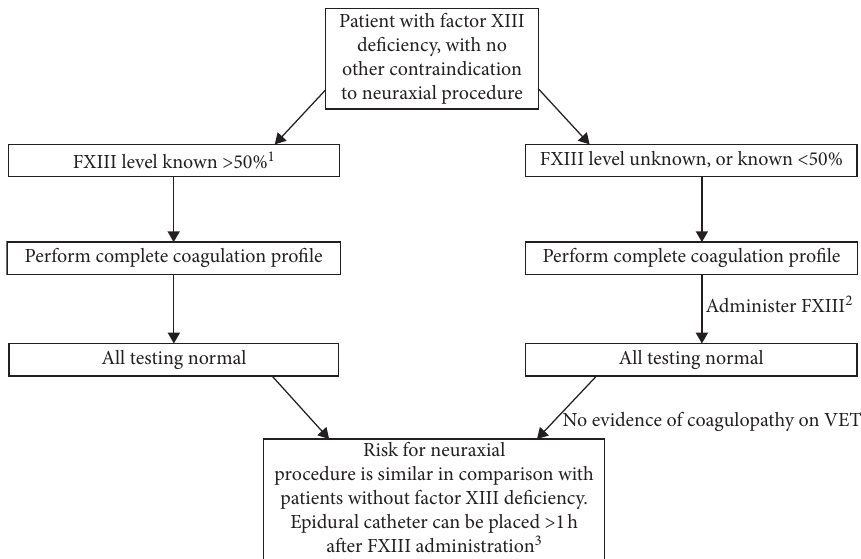
Figure 1: Algorithm for performing neuraxial procedures in patients with FXIII deficiency. VET: viscoelastic testing. 1 FXIII activity may be known by quantitative testing on admission, or calculated by a hematologist, taking into consideration patient’s medical conditions, comorbidities, timing of last dose, and quantitative assessment of prior response during the 3 rd trimester. 2 Administration of FXIII may be necessary because of the time required to obtain results of a quantitative FXIII test. FXIII dosing should be based on the recommendation of the hematologist, targeting level above 50%. 3 FXIII also confirmed or calculated above 50% for epidural catheter